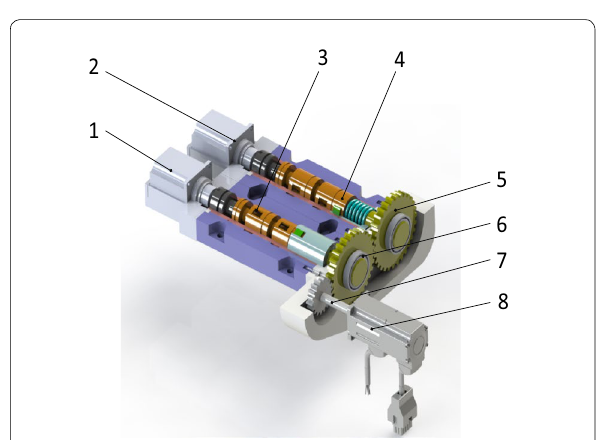
Figure 25 Vibration control twin-valve with independent control. 1. Linear motor 1; 2. Linear motor 2; 3. Rotary valve 1; 4. Rotary valve 2; 5. Large gear 1; 6. Large gear 2; 7. Small gear; 8. Servo motor